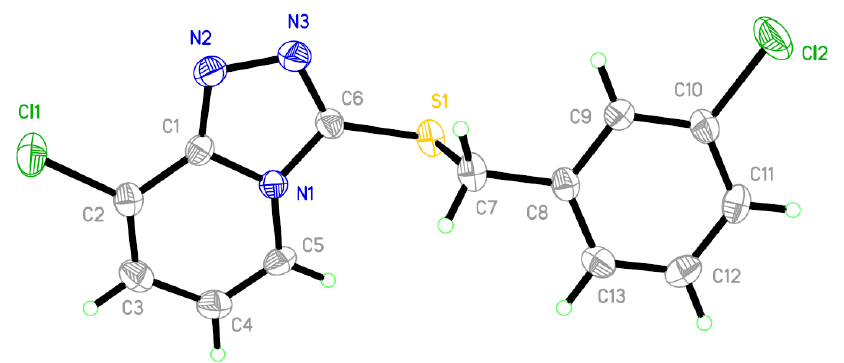
Figure 2. The molecular structure of the title